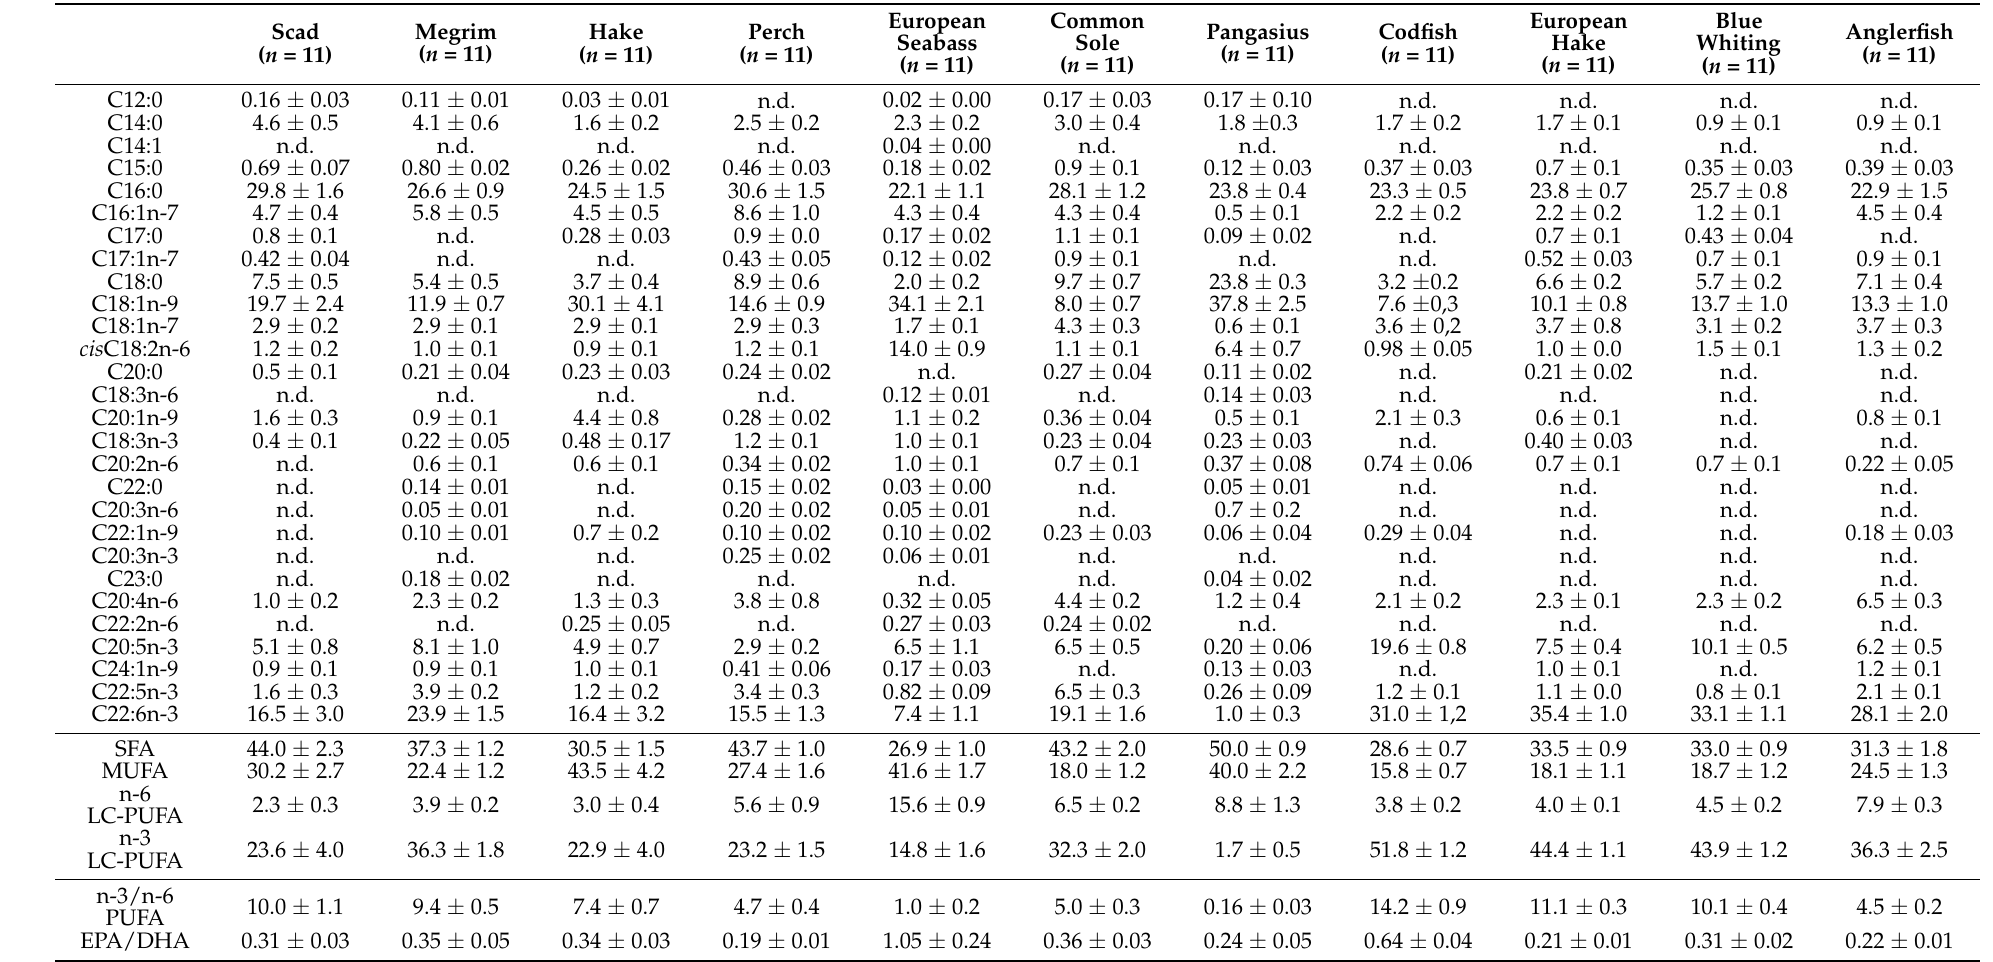
Table 3. Percentage of fatty acids in fresh white fishes usually consumed in